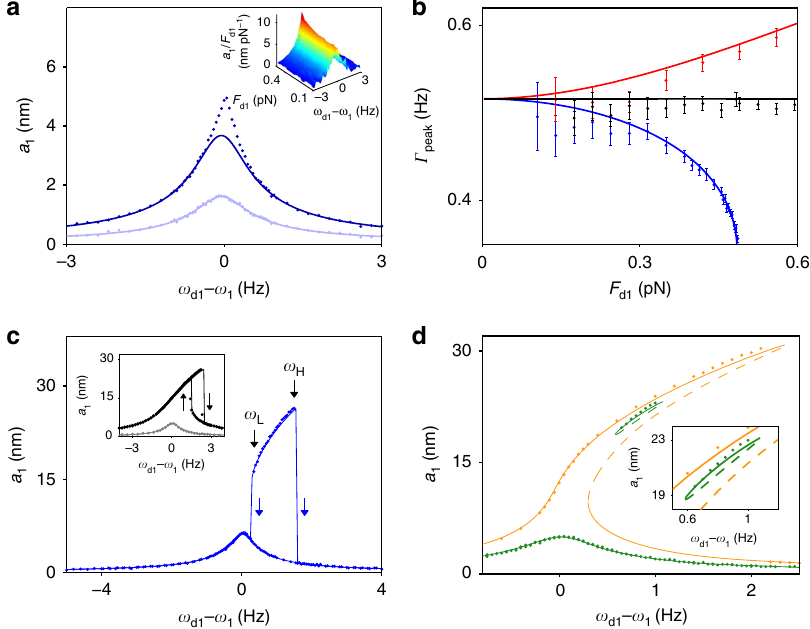
Fig. 4 Effect of negative nonlinear friction on the resonant response of the plate mode. a The amplitude of forced vibrations a 1 versus the driving force frequency ω d1 for Δ = 0 Hz and the driving force amplitudes F d1 = 0.21 pN (blue) and F d1 = 0.48 pN (dark blue). The blue line is a fi t to the linear regime. The dark blue line is obtained by multiplying the blue line by the drive amplitudes ratio 2.28. Inset: 3D plot of the measured ratio a 1 / F d1 . b The characteristic width Γ peak of the spectral peak versus drive amplitude for linear friction (black, no sideband pumping), and for positive/negative nonlinear friction (red/ blue, pumping at the red-/blue-detuned secondary sideband with Δ = 0 Hz). The solid lines are the theory (Supplementary Note 4). Error bars represent ±1 s.e. c Bistability of forced vibrations due to negative nonlinear friction, Δ = − 35 Hz. The driving force amplitude is 0.70 pN. At the bifurcation points ω L and ω H , the amplitude jumps down from the upper branch. Inset: with Δ = − 1000 Hz, nonlinear friction is negligible. Mode 1 displays a standard Duf fi ng hysteresis for F d1 = 3.5 pN (black); at F d1 = 0.70 pN no hysteresis occurs (gray). d Measured (dots) and calculated stable (solid lines) and unstable (dashed lines) vibration amplitudes for F d1 = 0.595 pN (green) and 0.980 pN (yellow). Inset: zoom in on the isolated